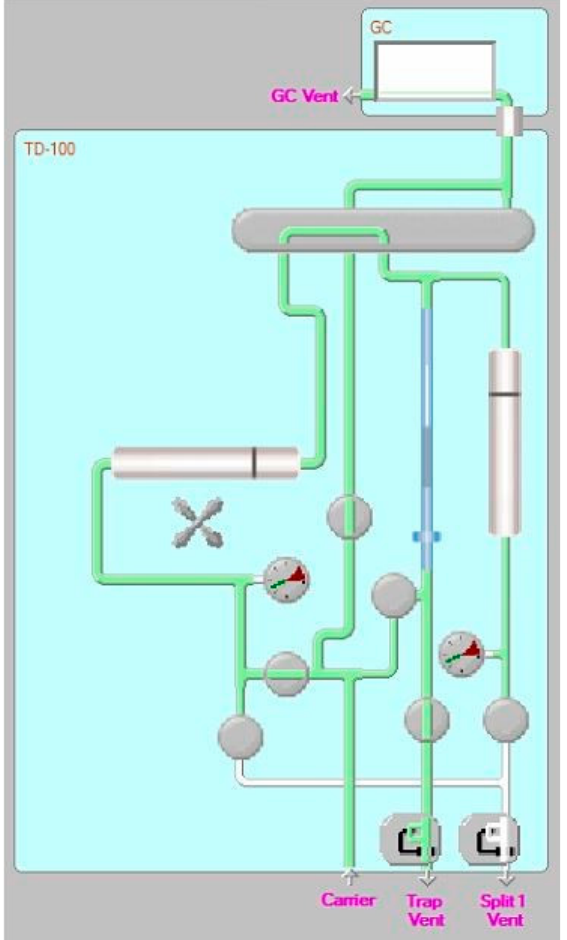
Figure 1. Operating diagram of the thermodesorber. The gas carrier flows to desorb the analytes from the tube (on the left) and focus them on the focusing trap (in light blue). The carrier is then ejected from the trap vent output.